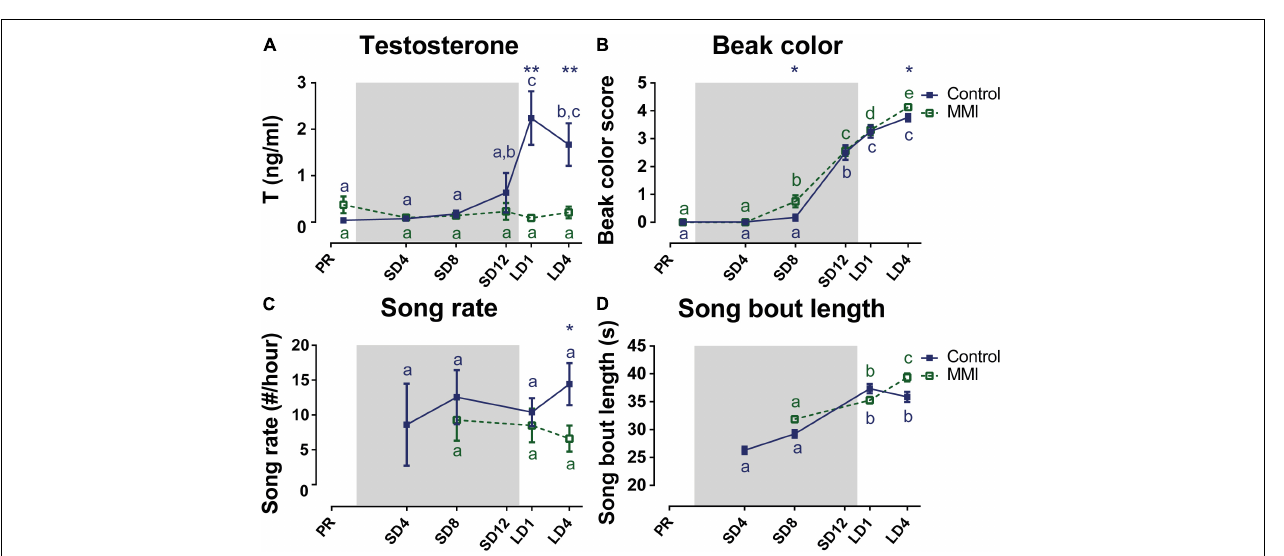
FIGURE 7 | Overview of the seasonal changes in testosterone plasma levels (A) , beak color (B) , song rate (C) , and song bout length (D) in control and MMI-treated starlings. Solid and dashed lines represent the group average of control and MMI-treated starlings respectively with standard errors of the mean error bars. The gray area indicates the photosensitive period of short days (8L:16D). Different letters denote significant differences by comparison with each other in post-hoc t -tests with p < 0.05 (Tukey’s HSD correction for multiple comparisons) comparing the different time points to each other. If two time points share a common letter, the factors are not significantly different from each